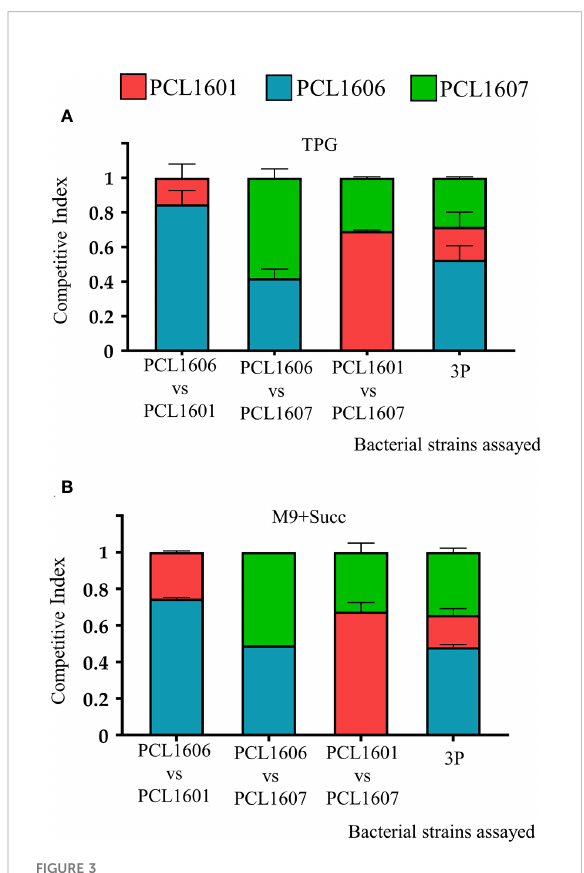
FIGURE 3 Competitive index (CI) in liquid media (TPG and M9+succ) calculated after 24 hours of growth at 25°C. All inocula were adjusted to an O.D. of 0.05 at 600 nm (10 5 cfu/ml). Then, dual and triple inoculations were made at the same proportion of 1:1 (1:1:1) in (A) TPG and (B) M9+succ. P. chlororaphis PCL1601 (red); P. chlororaphis PCL1606 (blue); P. chlororaphis subsp. piscium PCL1607 (red); 3P: combination of three Pc strains. Average competitive index (bar) and standard error (error bars) of three independent experiments are